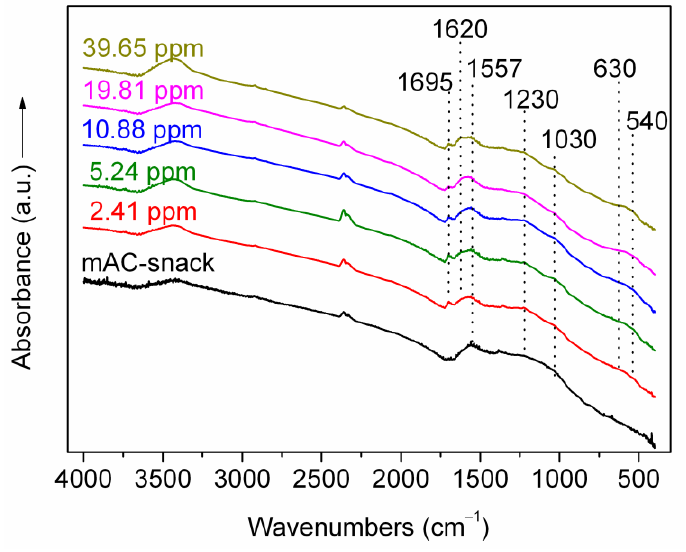
Figure 10. Infrared spectra of the mAC-snack before and after reaction with Cr(VI) solution at pH 3 in different initial concentration.